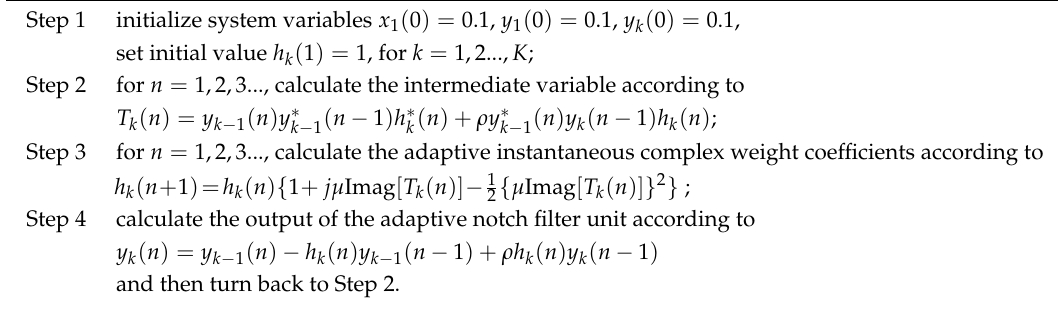
Table 2. The procedure of the linear cascaded high order complex-coefficient adaptive notch filter algorithm based on the basic one order adaptive notch filter